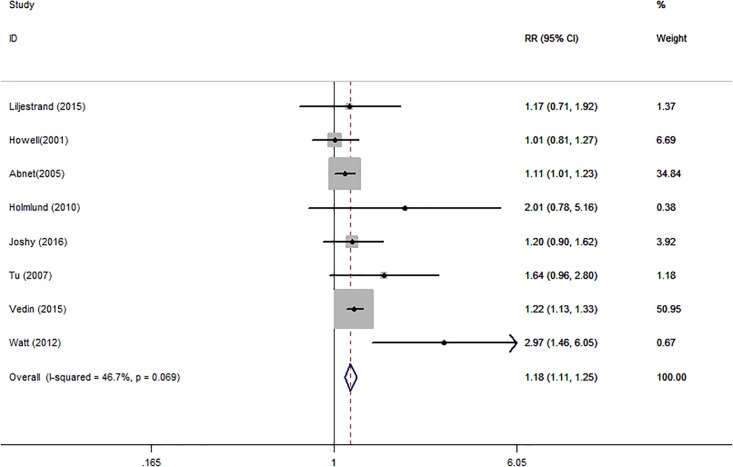
Forest plots for meta-analysis of tooth loss and risk of stroke.